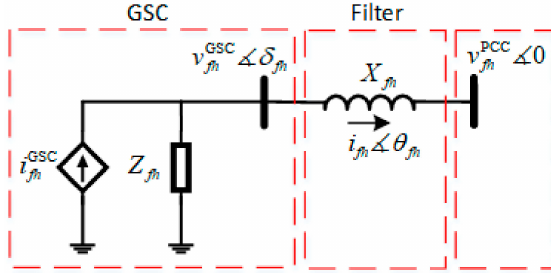
Figure 4. Harmonic model of ESSs in harmonic